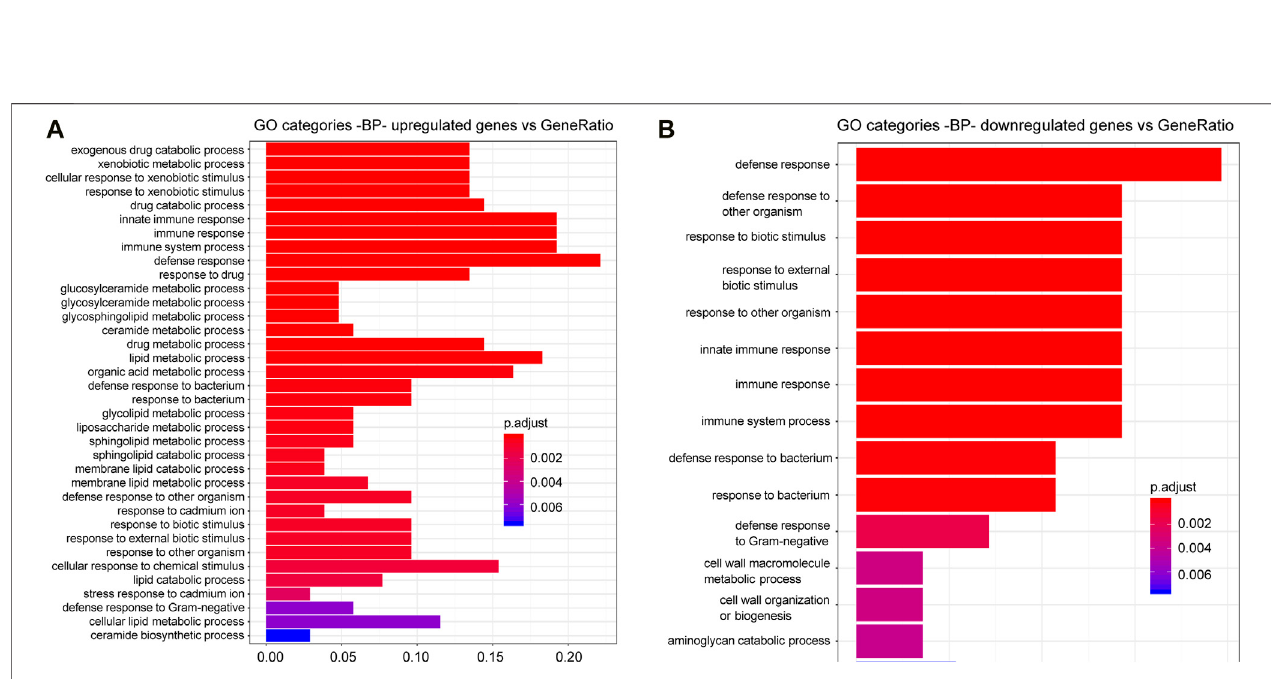
FIGURE8| C.elegans geneup-regulationanddownregulationinthepresenceofCGP37157.GeneOntology(GO)BiologicalProcesses(BP)vs.numberofgenes withineachcategoryappearsrepresentedincolorbars,1 barperGOterm.ThelengthofthebarsindicatesthenumberofgenesbelongingtothedifferentGOcategories and the color indicates the statistical signi fi cance, from those with highly signi fi cant expression difference (red) to those with lower signi fi cance (blue). Gene expression data were normalized by a negative binomial distribution model by using DESeq2 and EdgeR implementations and compared in pairs to analyze the effect of CGP37157 treatment. Common up-regulated (A) and down-regulated (B) genes determined by both methodologies were used for annotation and GO analyses.